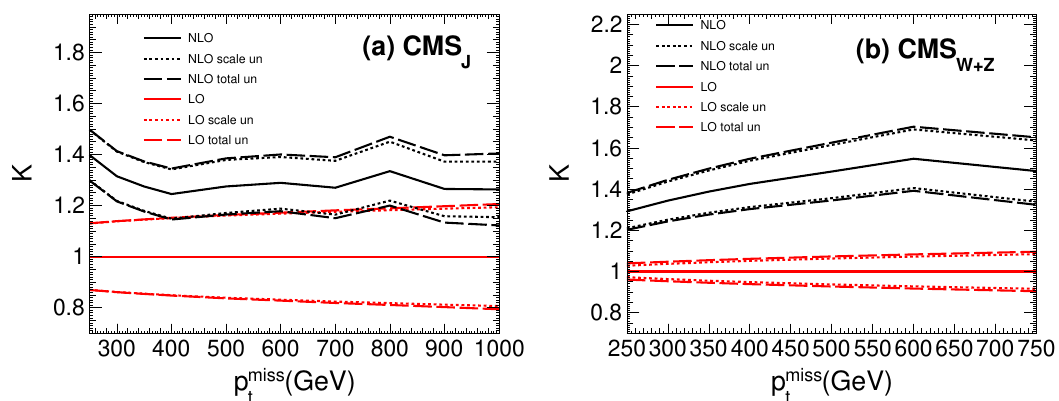
Figure 5. K-factors defined as ratio of NLO cross sections to LO cross sections for inclusive regions as a function of the lower threshold for CMS mono-jet and mono- W/Z on the left and right respectively, for a Z 0 mass of 100 GeV. The dashed (dotted) lines show the total (scale) uncertainties of the LO and NLO